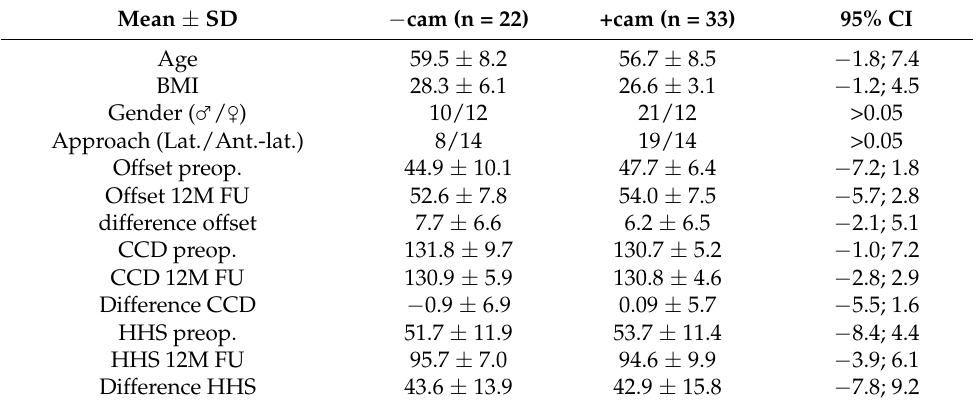
Table 1. Demographic data, approach data, hip morphology and clinical outcomes between both groups, +cam and − cam. Lat. = standard lateral hip approach, ant.-lat. = minimal-invasive antero- lateral hip approach. Both groups were comparable in terms of age, BMI, gender and approach ( p > 0.05). The +cam group showed a tendency towards younger patient age (2.8 years) and lower BMI